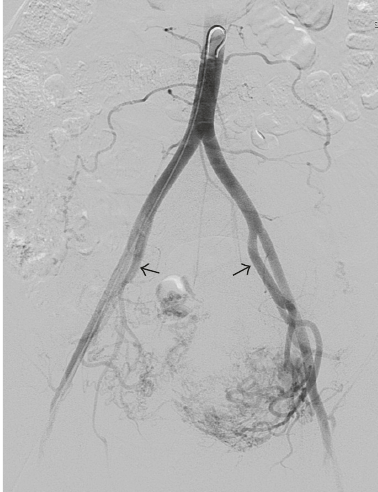
Figure 6: Microcatheter metal coil embolisation of the abnormal left internal iliac